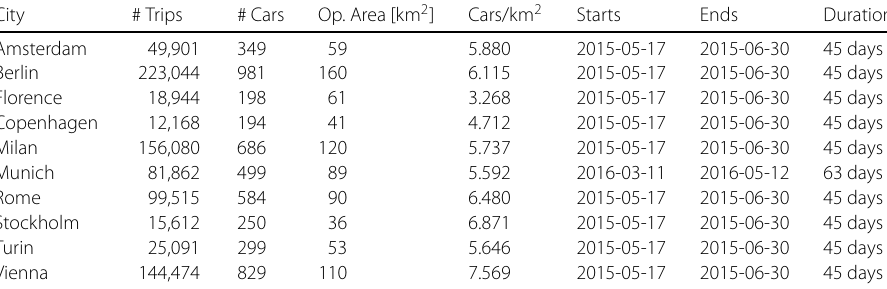
Table 2 Summary of dataset